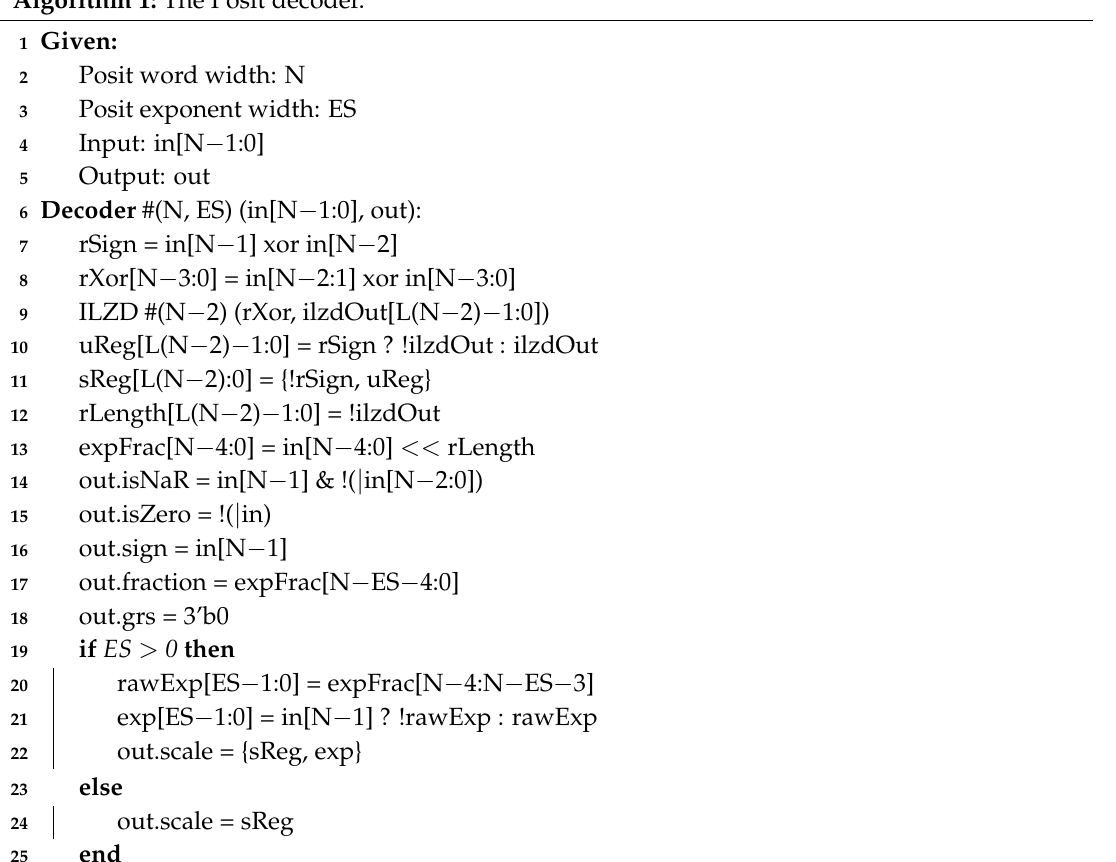
Algorithm 1: The Posit